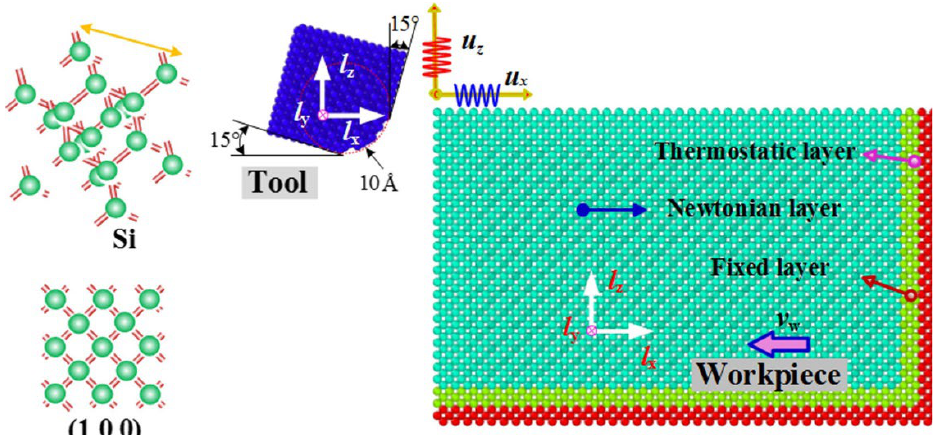
Figure 38. Molecular dynamics model of EVNC [200].